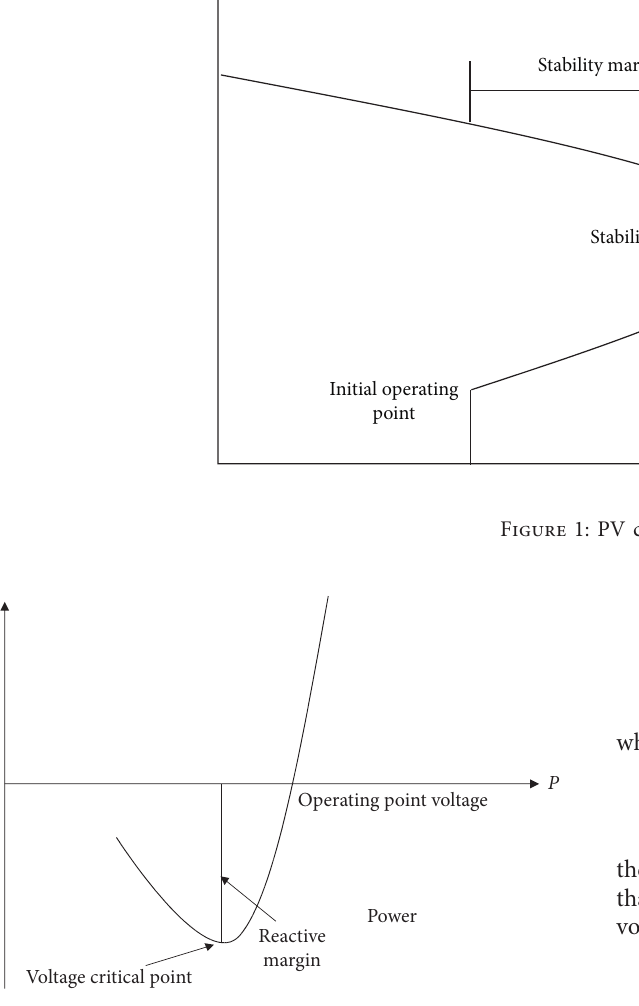
Figure 2: Normalised QV